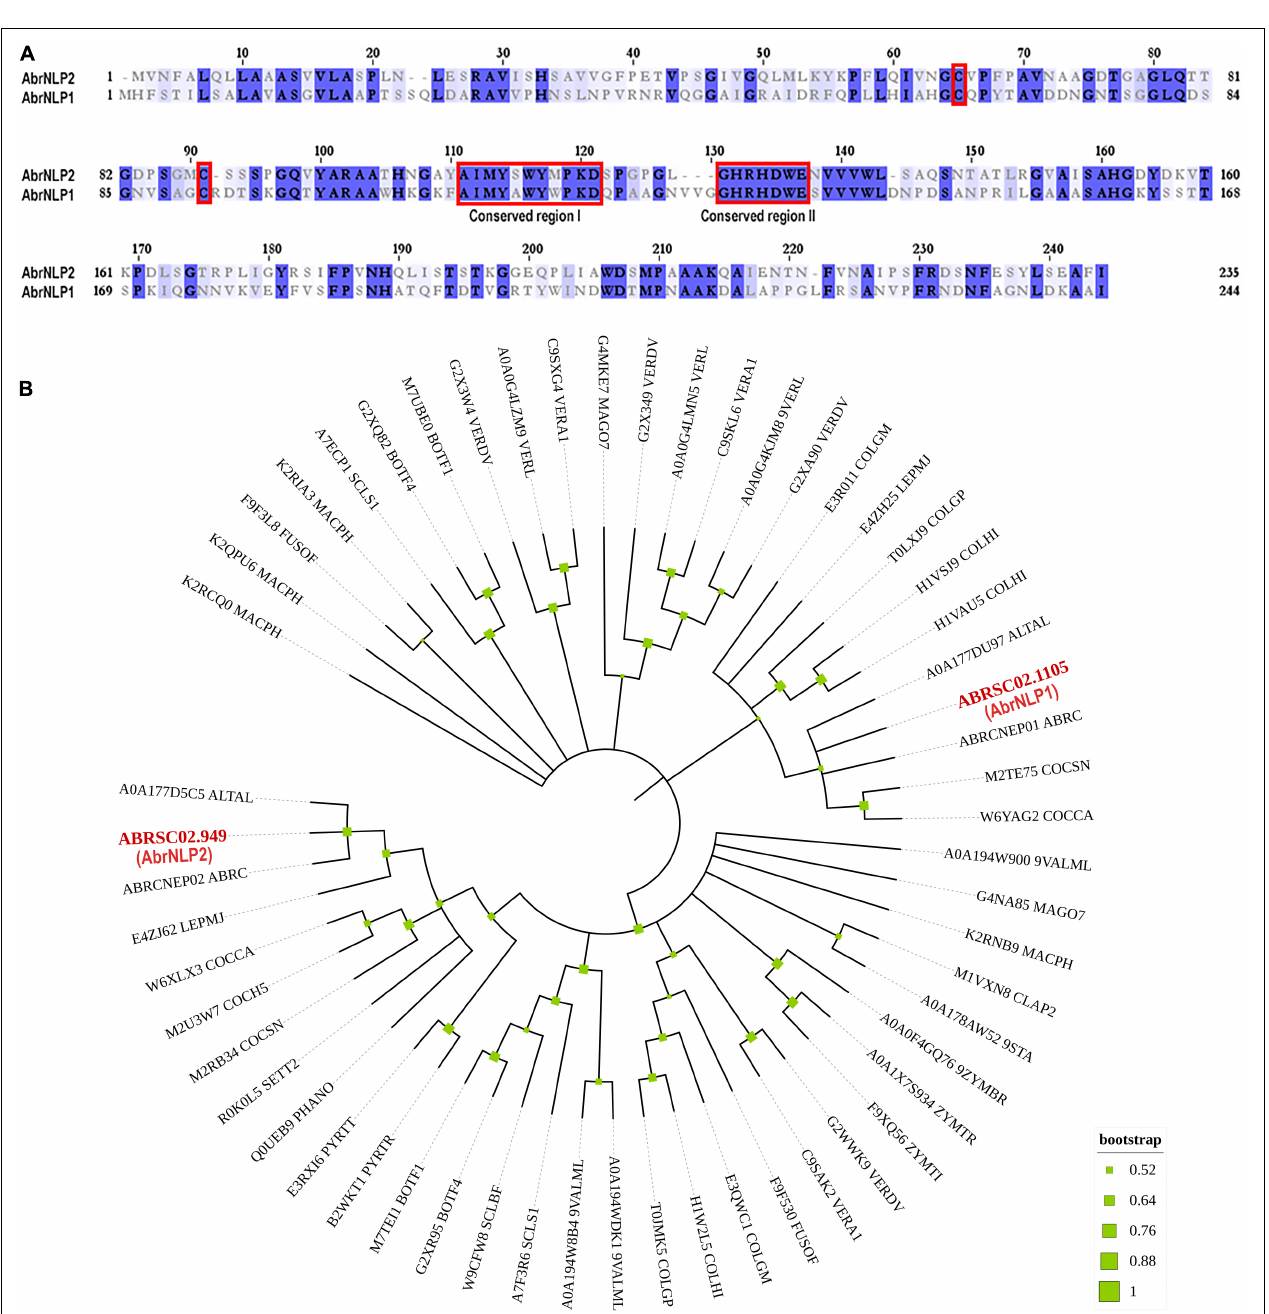
FIGURE 1 | Sequence characteristics of AbrNLPs and their phylogenetic relationship. (A) Multiple sequence alignment of NLPs from A. brassicae , the two conserved cysteines and conserved regions I and II that classify AbrNLPs as type I NLPs, are highlighted in red. (B) Phylogenetic relationship of AbrNLP1 and AbrNLP2 compared to the NLPs of other pathogens was inferred by using the Maximum Likelihood method. The bootstrap consensus tree was inferred from 1,000 replicates. Branches corresponding to partitions reproduced in less than 50% bootstrap replicates were collapsed. A discrete Gamma distribution was used to model evolutionary rate differences among sites [5 categories (+ G, parameter = 1.4565)]. All positions with less than 95% site coverage were eliminated, i.e., fewer than 5% alignment gaps, missing data, and ambiguous bases were allowed at any position.